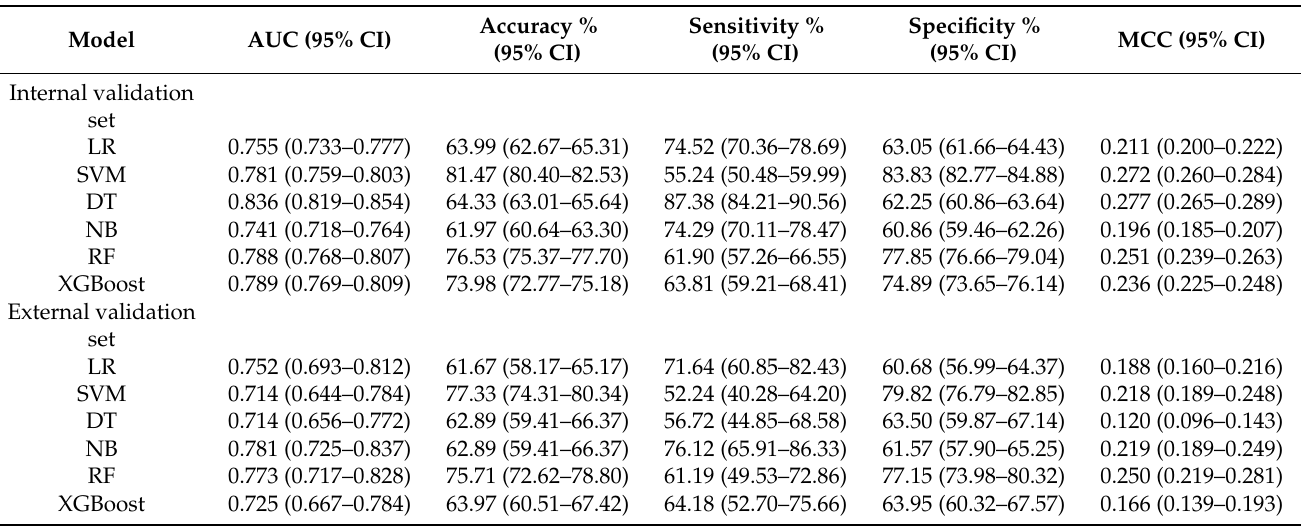
Table 4. Performance of different models for detecting HSIL+ among patients diagnosed as <HSIL by colposcopists.